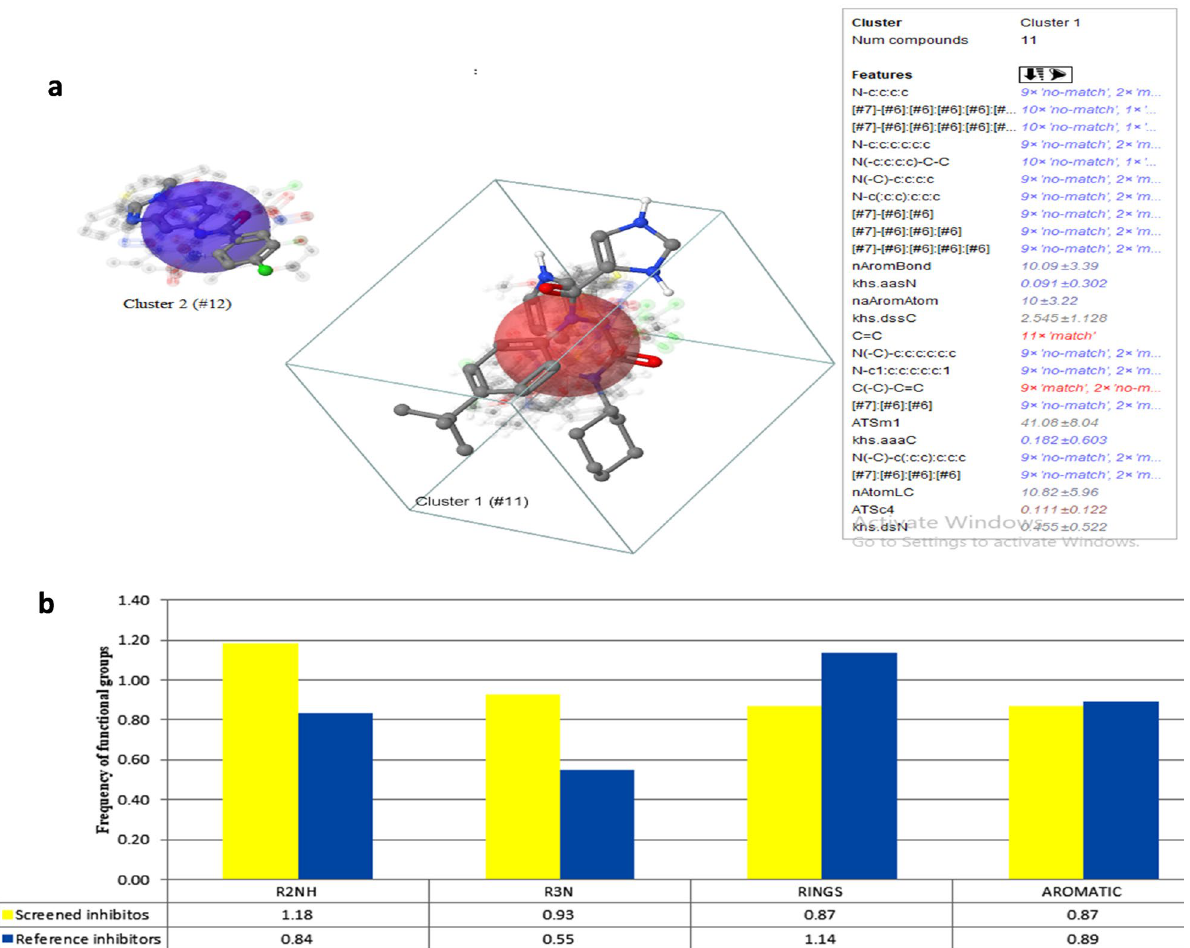
Figure 6. SAR and Functional group analysis: ( a ) cluster analysis in CheS-Mapper software, and ( b ) frequency of functional groups in screened inhibitors of cluster 2 and established reference inhibitors of